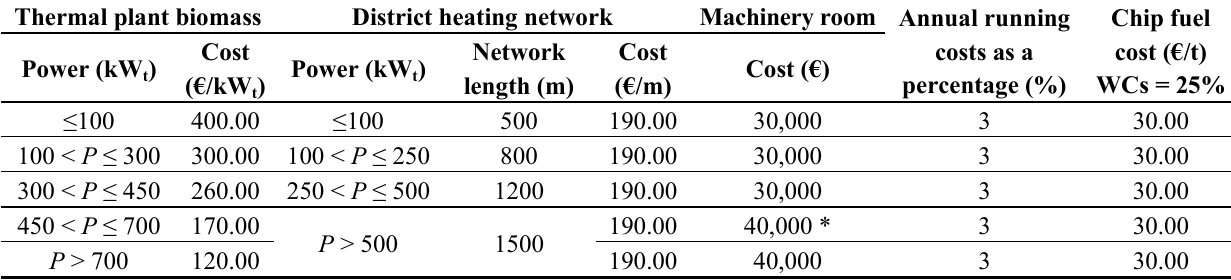
Table 8. Summary of panel installation costs and biomass supplies. Source: elaboration of the RU on